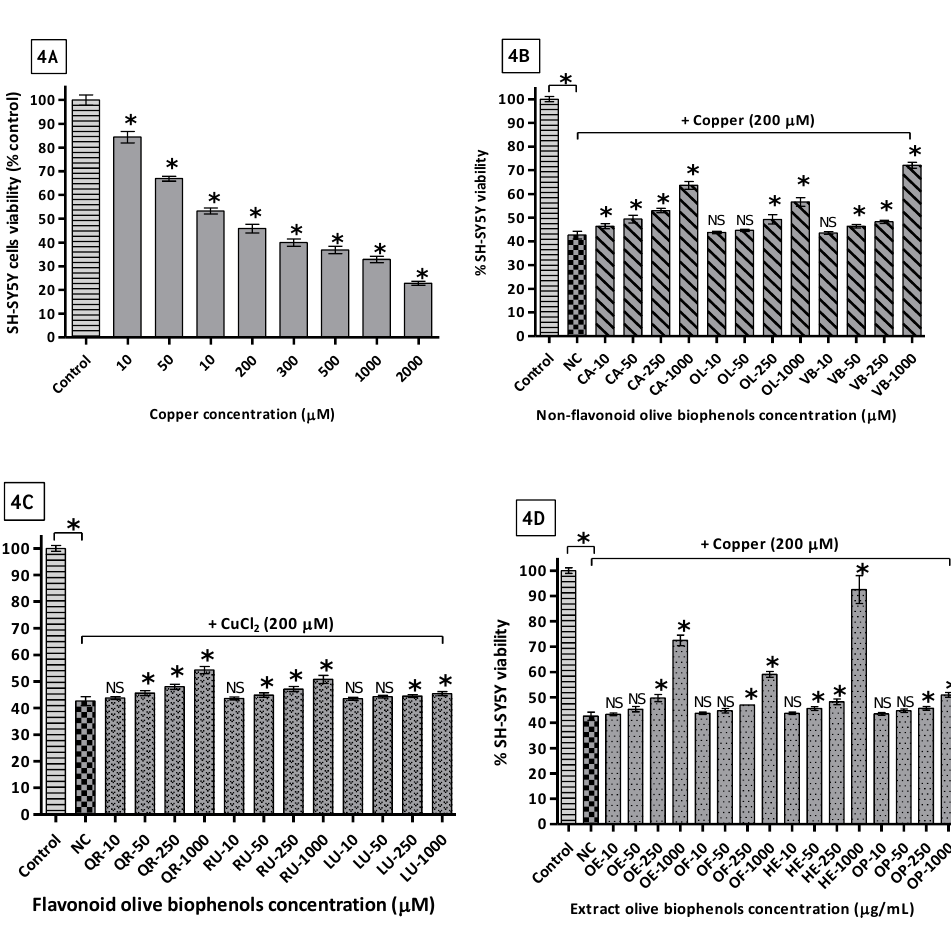
Figure 4. Copper-induced SH-SY5Y cells toxicity and protection by olive biophenols: SH-SY5Y cells were treated with different concentrations of copper for 24 h ( 4A ). SH-SY5Y cells were incubated with different concentrations of non-flavonoid olive biophenols ( 4B ), flavonoid olive biophenols ( 4C ) and extract olive biophenols ( 4D ) for 24 h followed by 200 μM of copper for 24 h. The results are mean ± S.E. of each parallel measurements analyzed by one way ANOVA (Tukey’s test), * p < 0.05 vs. control and negative control. NS: non-significant. PC: positive control (cells with media), NC: negative control (cells and H 2 O 2 without biophenols), CA: caffeic acid, OL: oleuropein, HT: hydoxytyrosol, VB: verbascoside, QU: quercetin, RU: rutin, LU: luteolin, OLE: olive leaf extract, OFE: olive fruit extract, HTE: Hydroxytyrosol extreme TM , OLP: Olivenol plus TM .